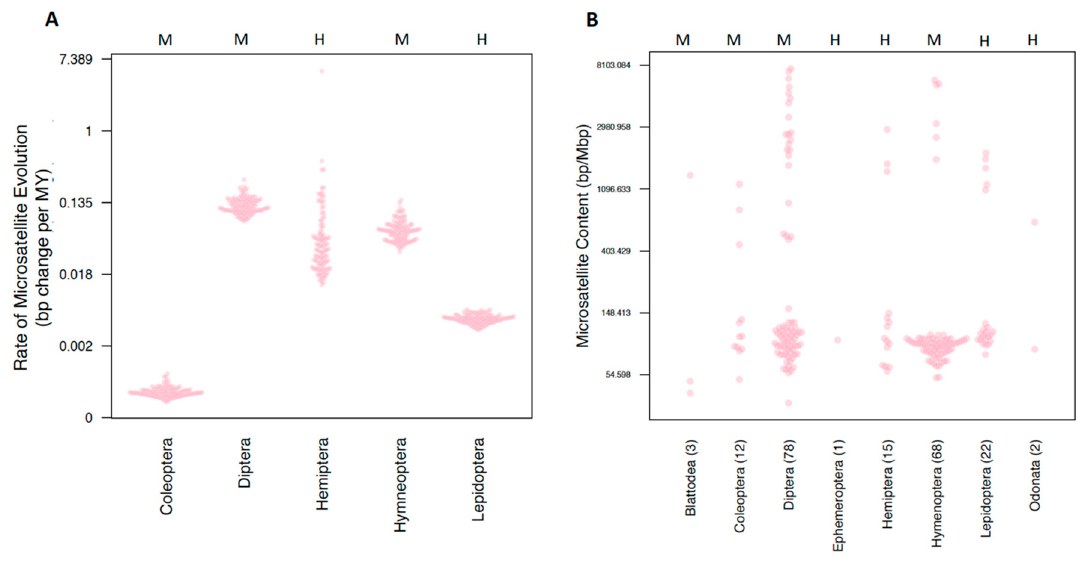
Figure 2. Comparing microsatellite content and rates of evolution among orders. Both y -axes are measured in a log scale. The centromere type present in an order is indicated with an H or M at the top of the plot for holocentric and monocentric, respectively. Orders are indicated on the horizontal axis. ( A ) The rate of microsatellite evolution for all orders with at least 10 representatives. For each order, 100 estimates derived from each of the 100 trees is plotted. ( B ) Microsatellite content for all species included in comparative analyses.